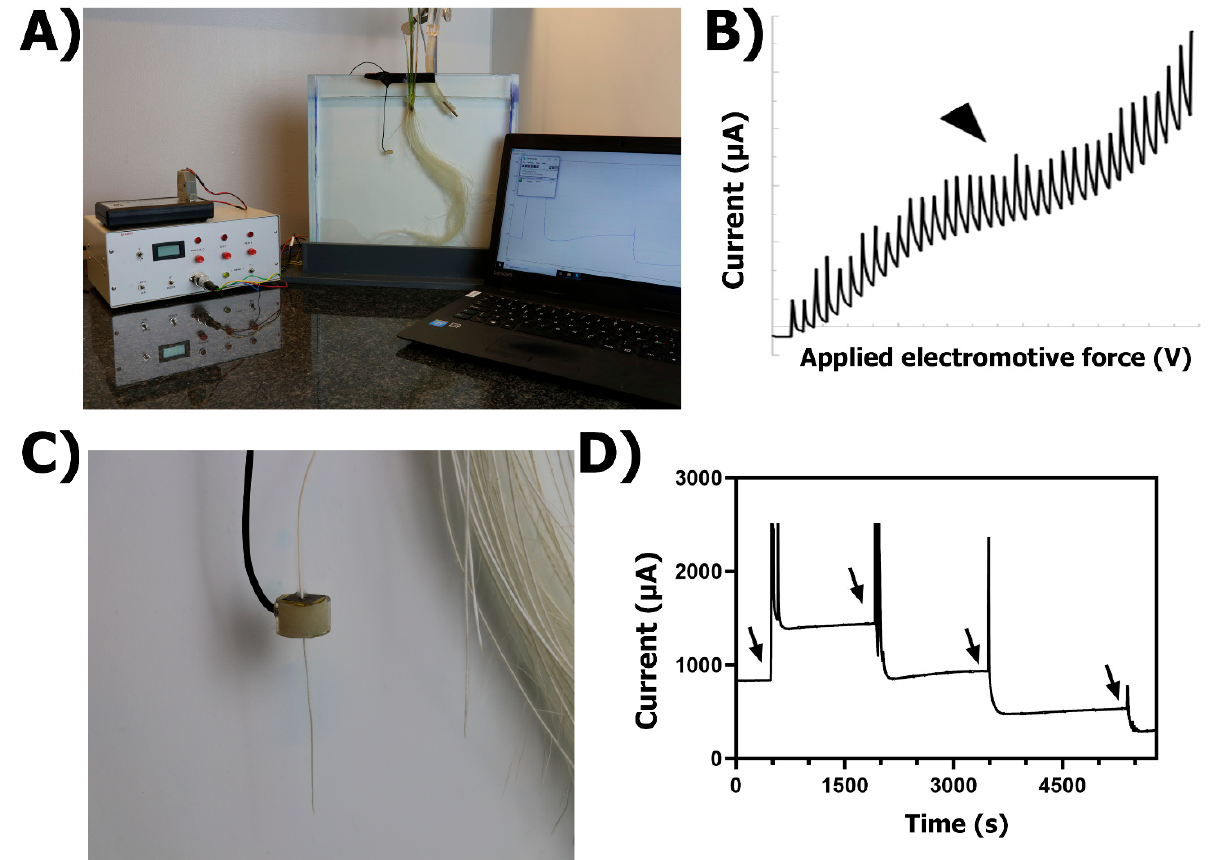
Figure 3. Polarographic method for radial O 2 loss determination in roots. ( A ) General set-up including a transparent acrylic chamber filled with deoxygenated solution and the roots of an intact rice plant submerged. Different electrodes (see text for details) are inserted into the deoxygenated solution and connected to a polarograph. ( B ) Current–voltage curve for O 2 determination in solutions. ( C ) Close-up of a root inserted into a Pt-sleeving electrode. ( D ) Diffusion current from the Pt-sleeving electrode. Arrowhead in B points to current plateau where the rate of O 2 reduction is independent of voltage and only depends on the rate of O 2 diffusion to the cylindrical electrode surface. Arrows in D indicate the points when Pt-sleeving electrode was moved in 10 mm steps from basal parts toward the tip of a root of Hordeum marinum grown in aerated solutions. Note the time taken for current stabilization before a new measurement.